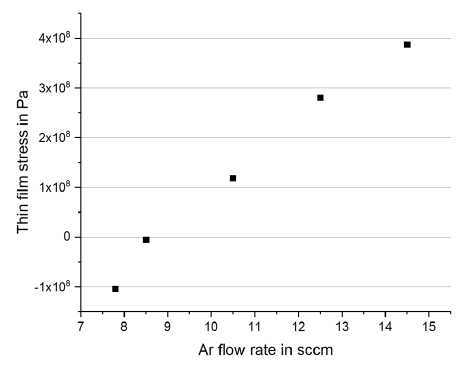
Figure 2. Intrinsic stress of the sputtered FeSiB against the Ar flow rate during sputtering.